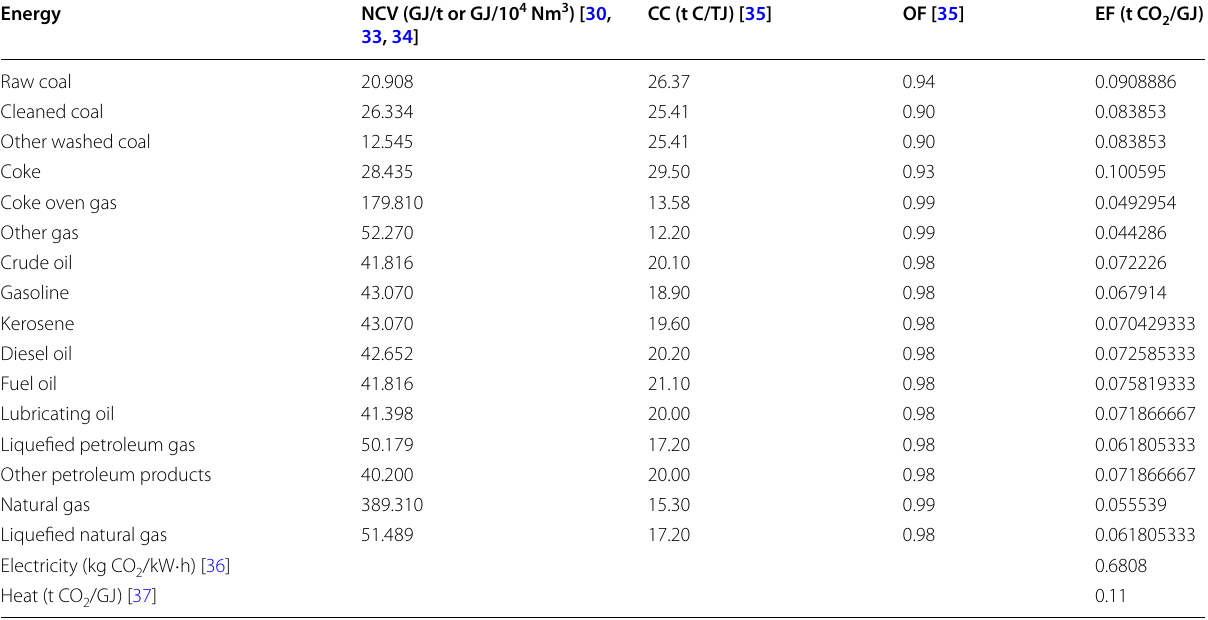
Table 1 Reference data for the different kinds of